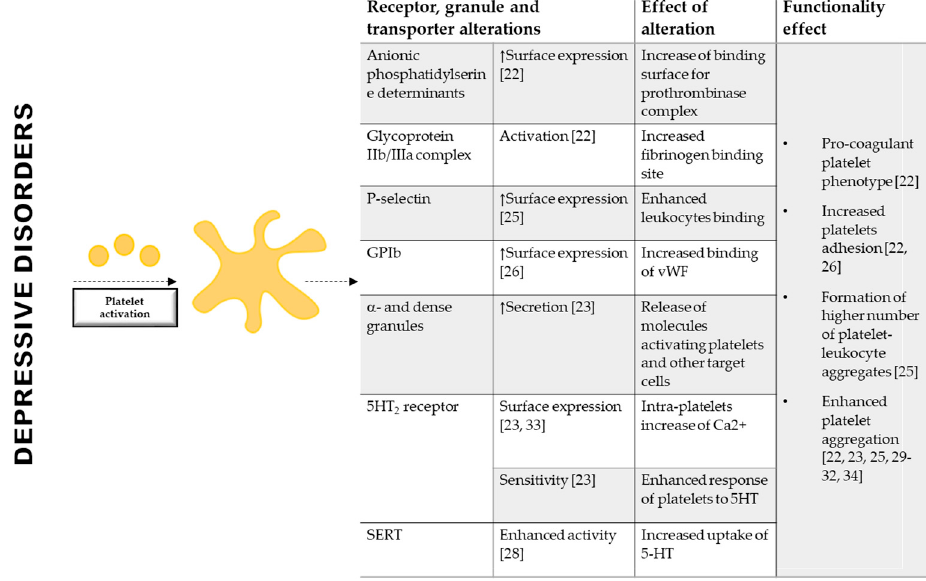
Figure 1. Platelets of depressed patients show hyper-reactivity. Patients with depression, show hyper-reactive platelets. Indeed, platelets of depressed patients display a greater exposure of anionic phosphatidylserine determinants, an increased activation of Glycoprotein IIb/IIIa, a higher expression of P-selectin and Glycoprotein Ib, an increased expression and sensitivity of 5HT 2 receptor, an enhanced activity of SERT and an enhanced aggregation and sensitivity in response to collagen thrombin, and serotonin. Platelet hyper-reactivity is also confirmed by a greater platelet granules secretion. GP: Glycoprotein; vWF: von Willebrand Factor; 5-HT: 5-Hydroxytriptamine; 5-HT 2 : 5-HT receptor; SERT: plasma membrane serotonin transporter. ↑ : increased compared to